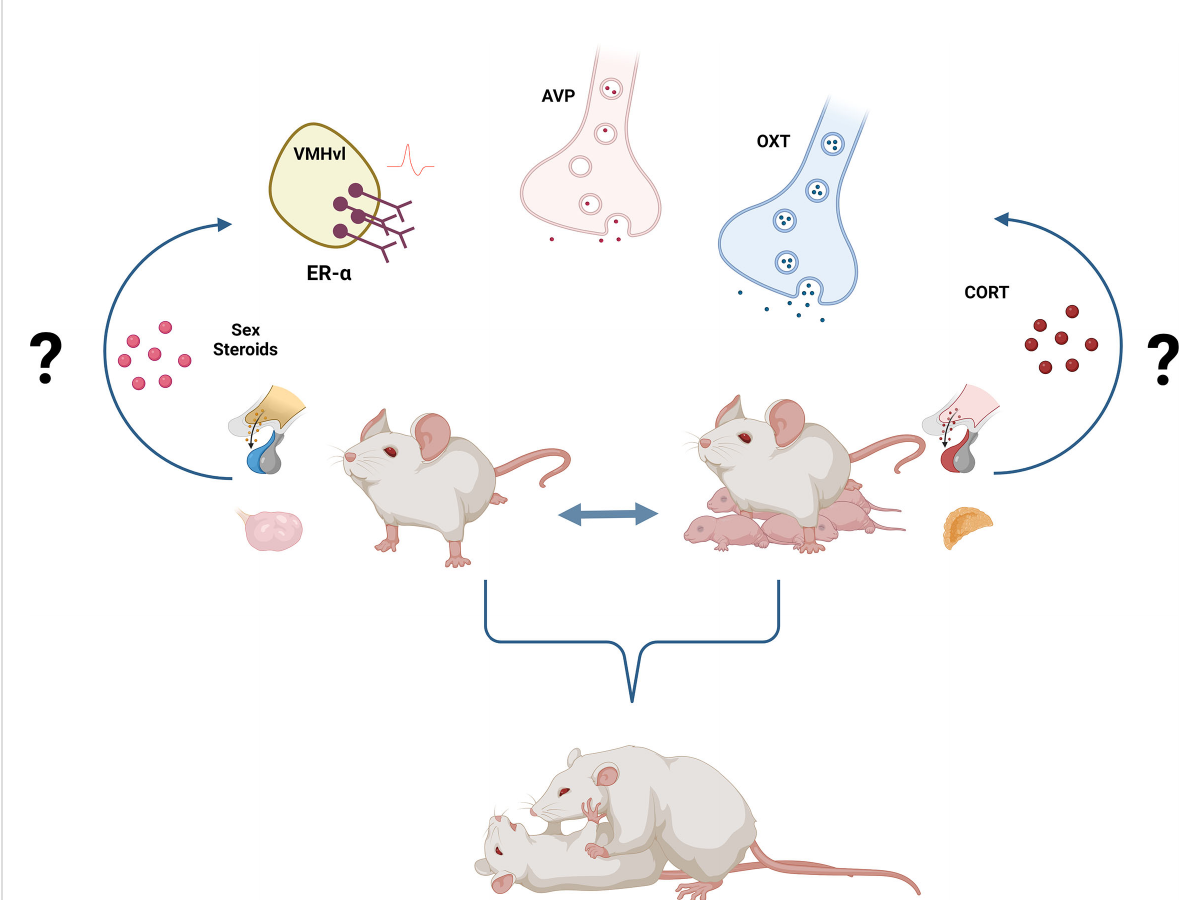
FIGURE 1 Neuroendocrine regulation of female aggression. Activation of ER- a + neurons in the VMHvl as well as increased OXT and decreased AVP signaling underly female aggression, independently of the reproductive state. Yet, the activational, as well as the organizational role of sex steroids either activating ER- a + neurons or masculinizing/feminizing the neural circuitry of female aggression remains poorly understood. Similarly, the well-established link between stress, hypothalamic-pituitary-adrenal (HPA) axis, corticosterone, and aggressive behavior needs to be further dissected in females. Created with BioRender.com.